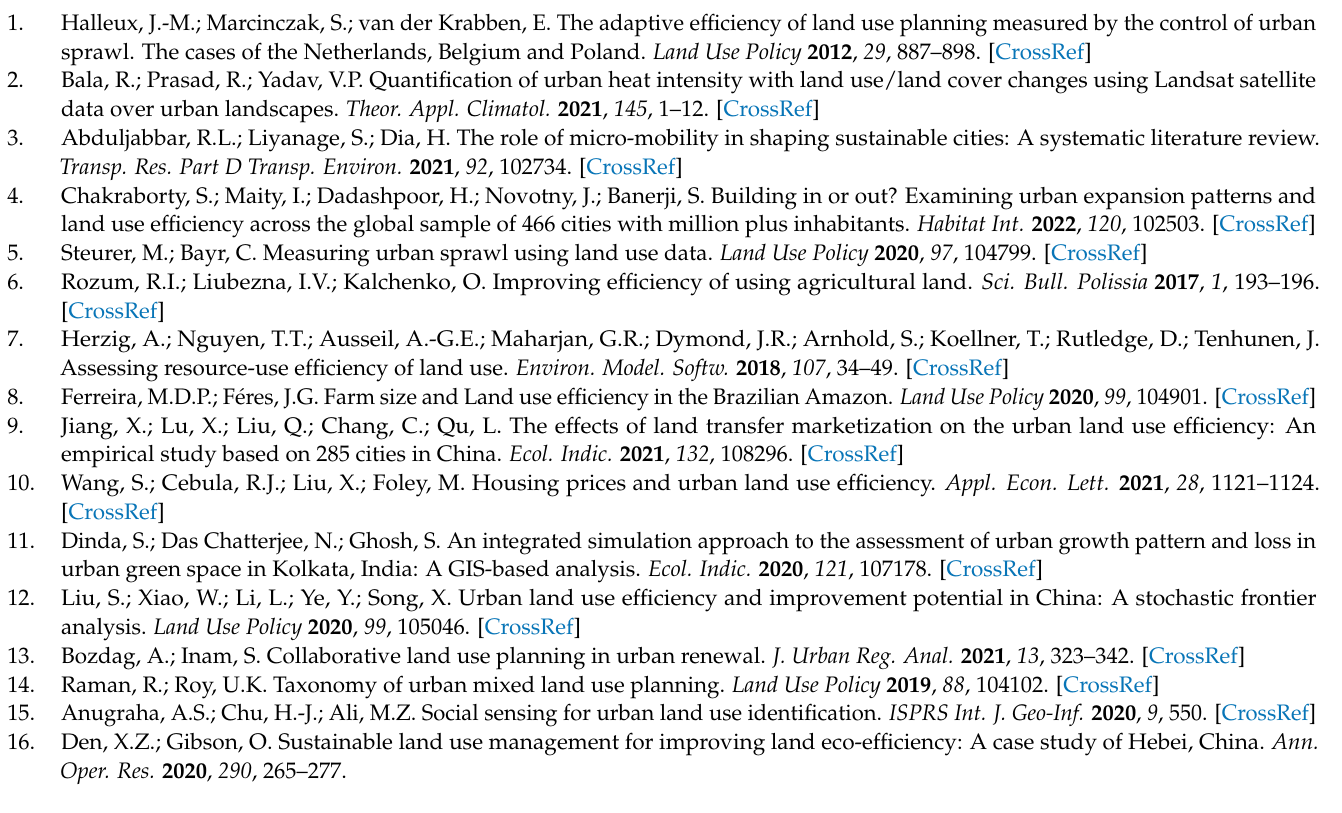
in 2010. Table S2: CGLUE factors values of 11 counties in 2011. Table S3: CGLUE factors values of 11 counties in 2012. Table S4: CGLUE factors values of 11 counties in 2013. Table S5: CGLUE factors values of 11 counties in 2014. Table S6: CGLUE factors values of 11 counties in 2015. Table S7: CGLUE factors values of 11 counties in 2016. Table S8: CGLUE factors values of 11 counties in 2017. Table S9: 2019. Table S11: CGLUE factors values of 11 counties in 2020. Table S12: 11 Counties CGLUE